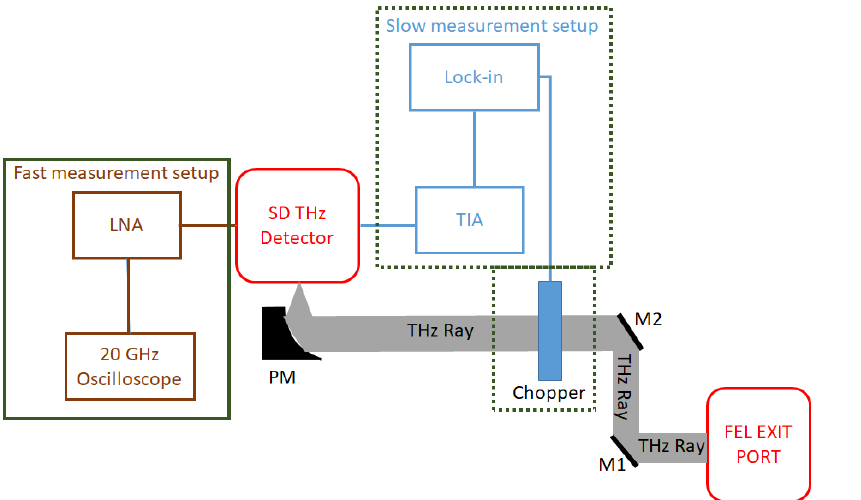
Figure 3. Experimental setup used at FELBE. The solid green box components show the measurement setup for detection of the sub-ns scale signal, while the components in dashed green box shows the slow measurement setup that visualize both slow thermal as well as fast rectification processes. In the setup, PM: Parabolic mirror, LNA: Low noise amplifier, M1 & M2: Mirror and TIA: Trans- impedance